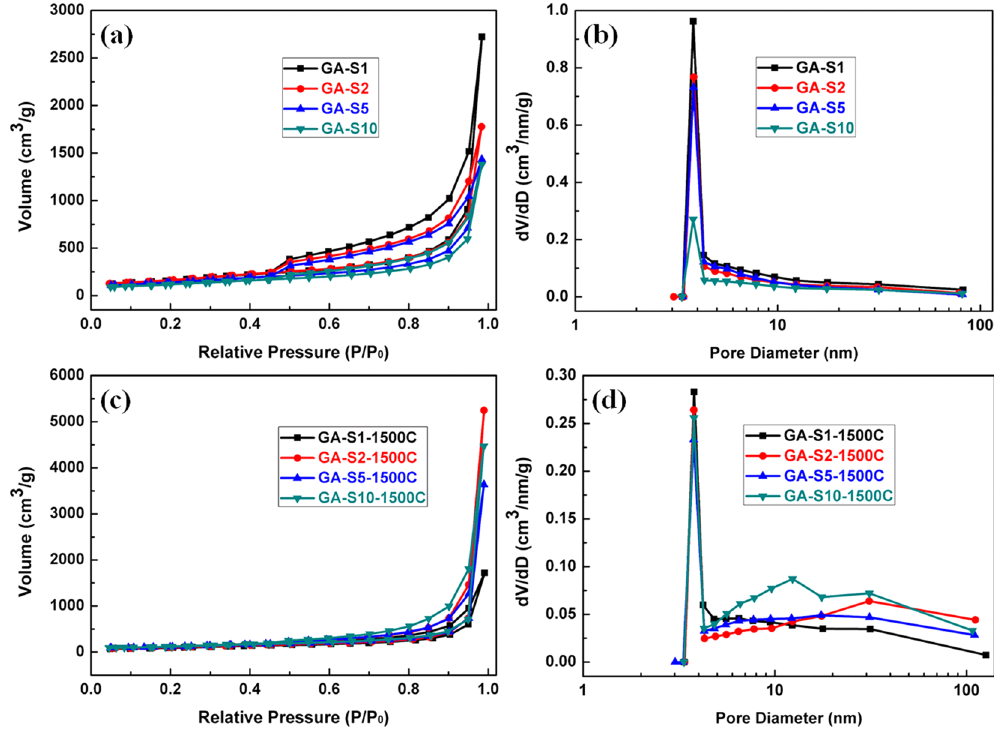
Figure 3. Nitrogen adsorption–desorption isotherms and Barrete-Joynere-Halenda (BJH) desorption pore distribution plots of ( a and b ) GA-S and ( c and d )